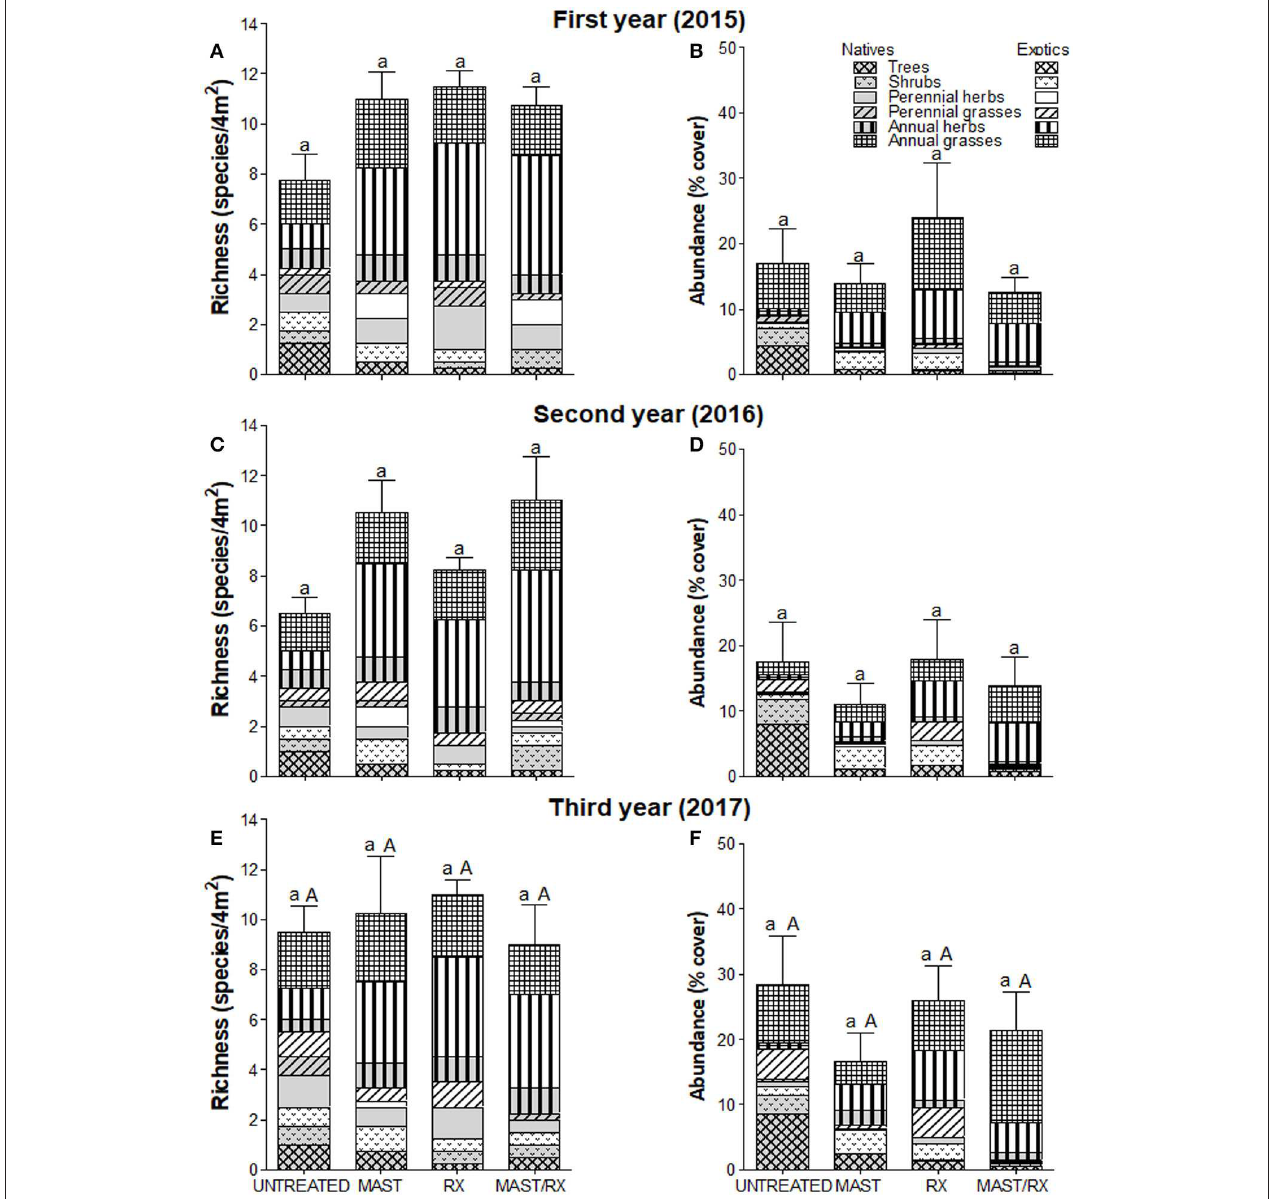
FIGURE 7 | Vegetation richness (A,C,E) and abundance (B,D,F) by origin and growth form in each fuel treatment for the first (A,B) , the second (C,D) , and the third (E,F) years in site 5. Bars indicate total richness and abundance SE , respectively. Different small letters indicate differences among fuel treatments for each year (differences among years for each fuel treatment are not represented), and capital letters indicate differences among fuel treatments for the third year. Treatments are as follows: residues on the floor (UNTREATED), mastication (MAST), prescribed fire (RX), mastication plus prescribed fire (MAST/RX), and steppe vegetation (STEPPE).